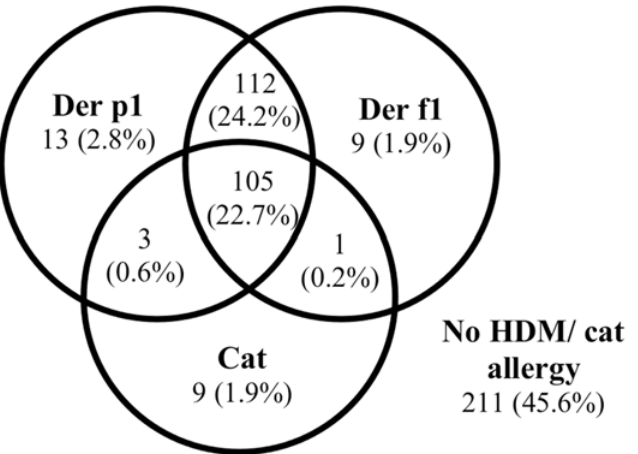
Fig 1. Venn diagram for the distribution of subjects with a positive skin prick test to D . pteronyssinus , D . farinae and Felis domesticus in the group with skin prick test (n = 463).